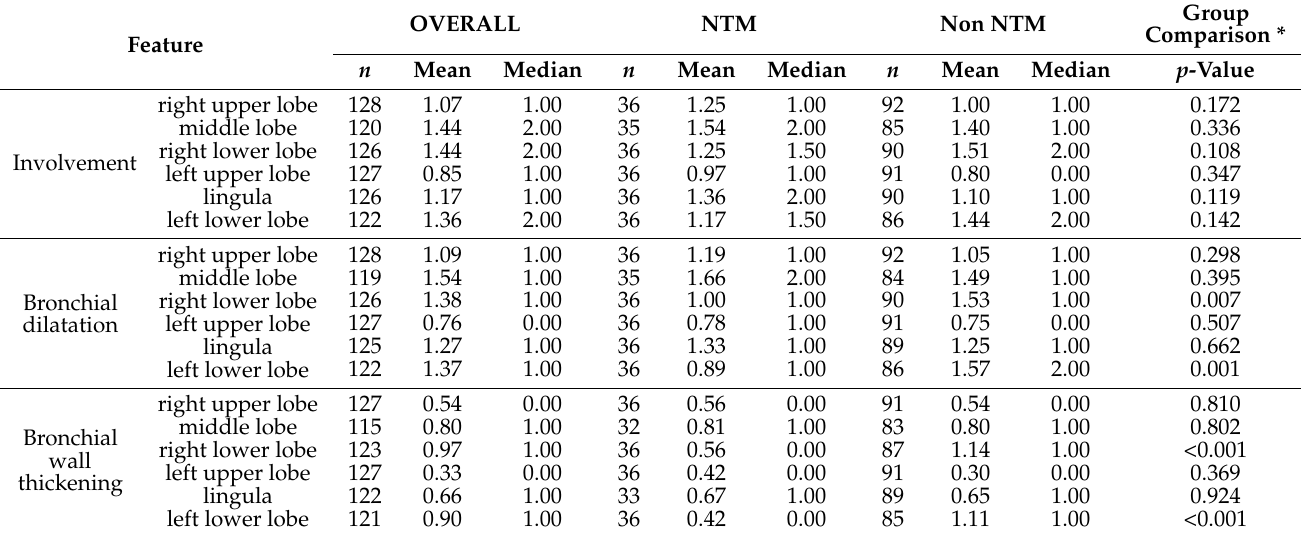
Results of the Reiff-Score for all patients with bronchiectasis and separately for those with and without NTM-PD. * Group comparisons between patients with and without NTM-PD were performed using the Mann–Whitney U-test. Not all features could be evaluated in all lobes due to lobe resections and